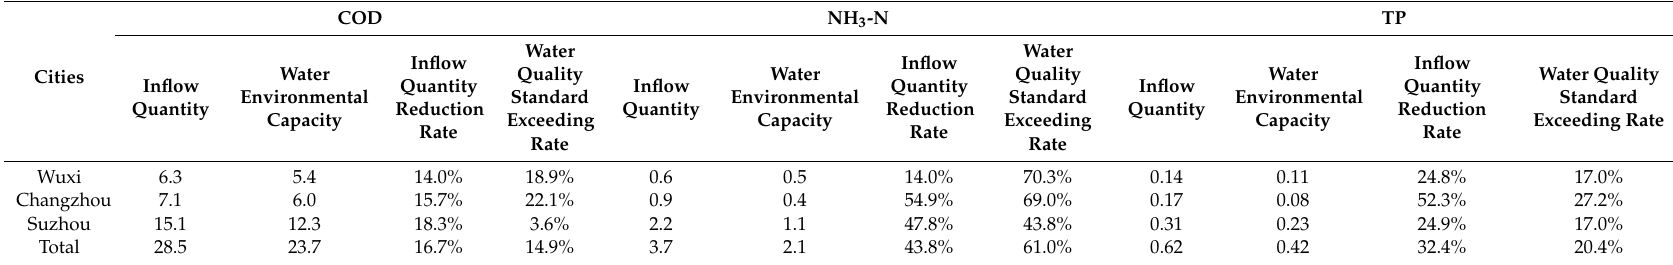
Table 2. Rationality analysis of the calculation value of water environment capacity in cities in the Taihu Lake Basin in Jiangsu Province (unit: 10,000 t / a). COD NH 3 -N TP Cities Inflow